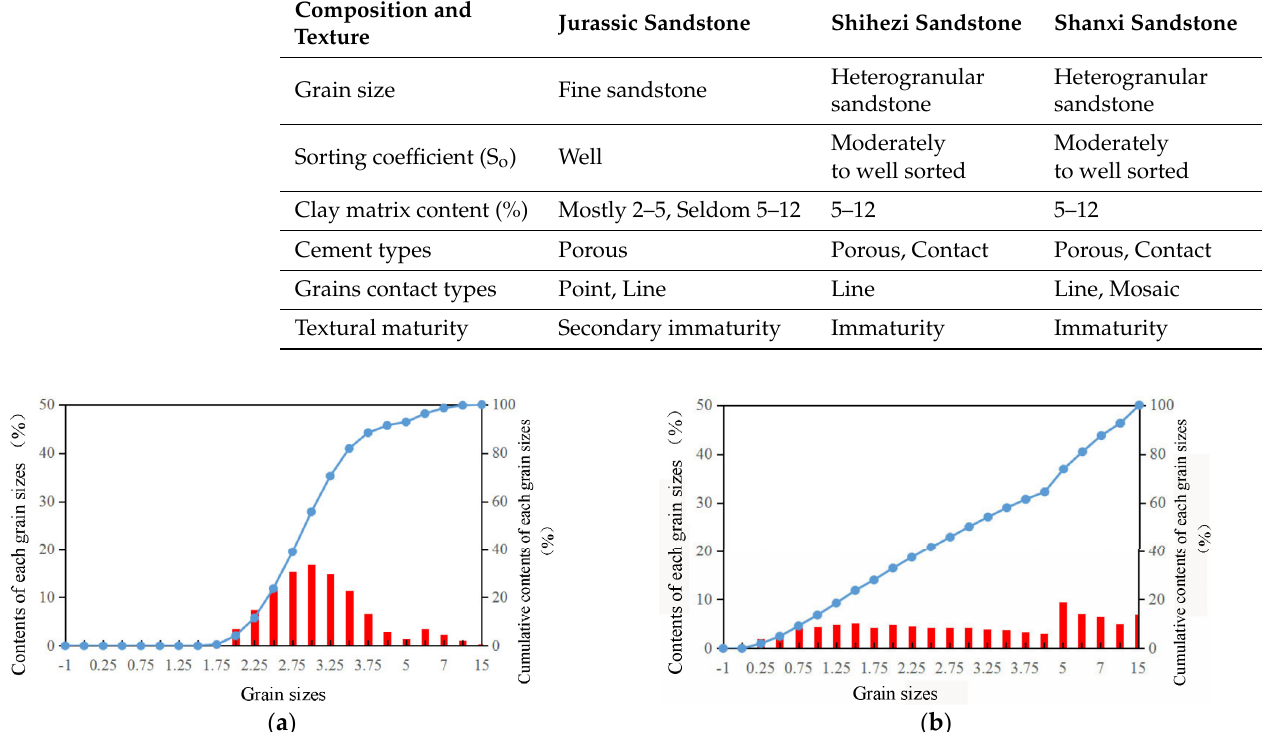
Table 5. The compositional and textural properties of the three layers of sandstone.